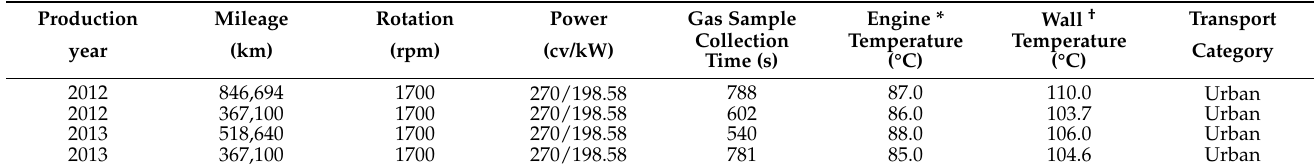
Table 2. Engine parameters and operating conditions along gas sampling. Steady state and working temperature similar to the on-load